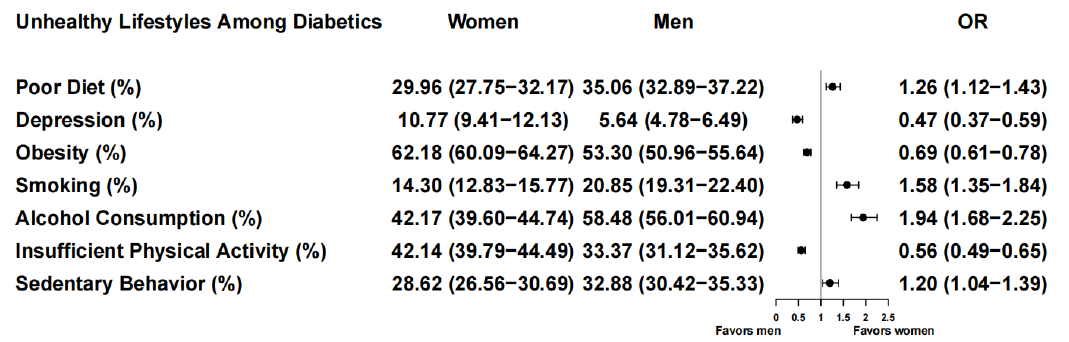
Figure 2. Gender differences in unhealthy lifestyle behaviors in the 1999 to 2018 NHANES surveys. Odds ratios (OR, 95% CI) of women vs. men to evaluate the association between gender and unhealthy lifestyle behaviors in adults with diabetes (poor diet, depression, obesity, smoking, alcohol consumption, insufficient physical activity and sedentary behavior). Women served as the reference group.